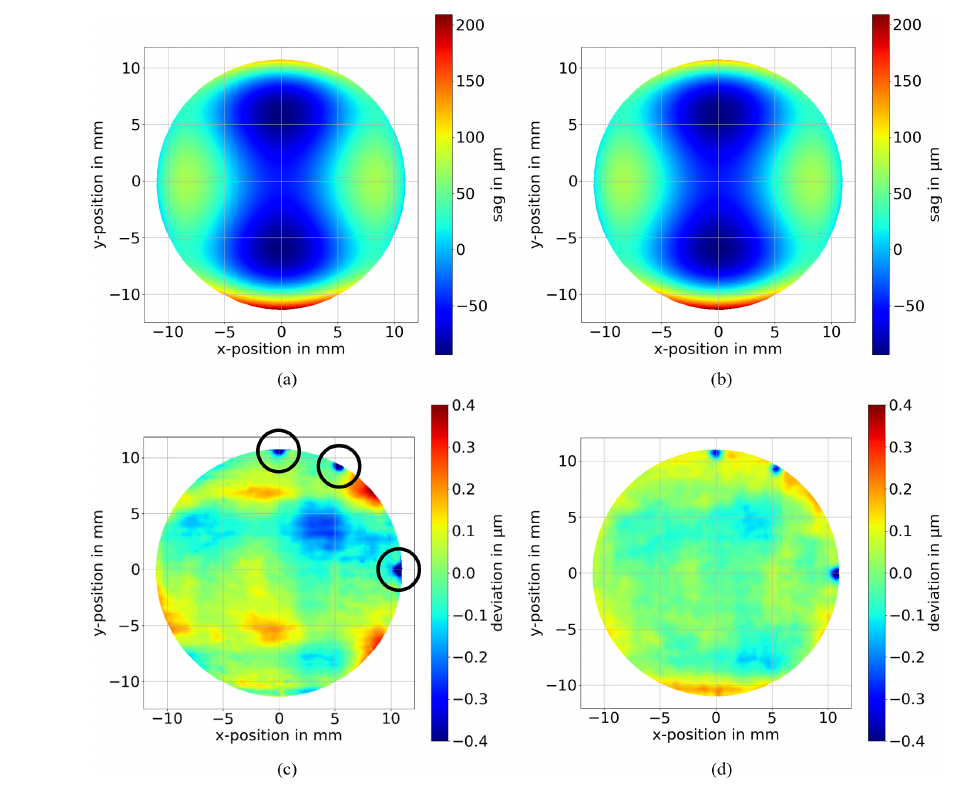
Figure 11. Results of the experimental measurement of the polynomial freeform. Panel (a) shows the reconstructed surface. Panel (b) shows the expected model. Panel (c) shows the deviation from the expected model of the SUT. The rms surface deviation is 94nm. The circles indicate fiducials implemented for better orientation. Panel (d) shows the comparison measurement from the manufacturer performed using